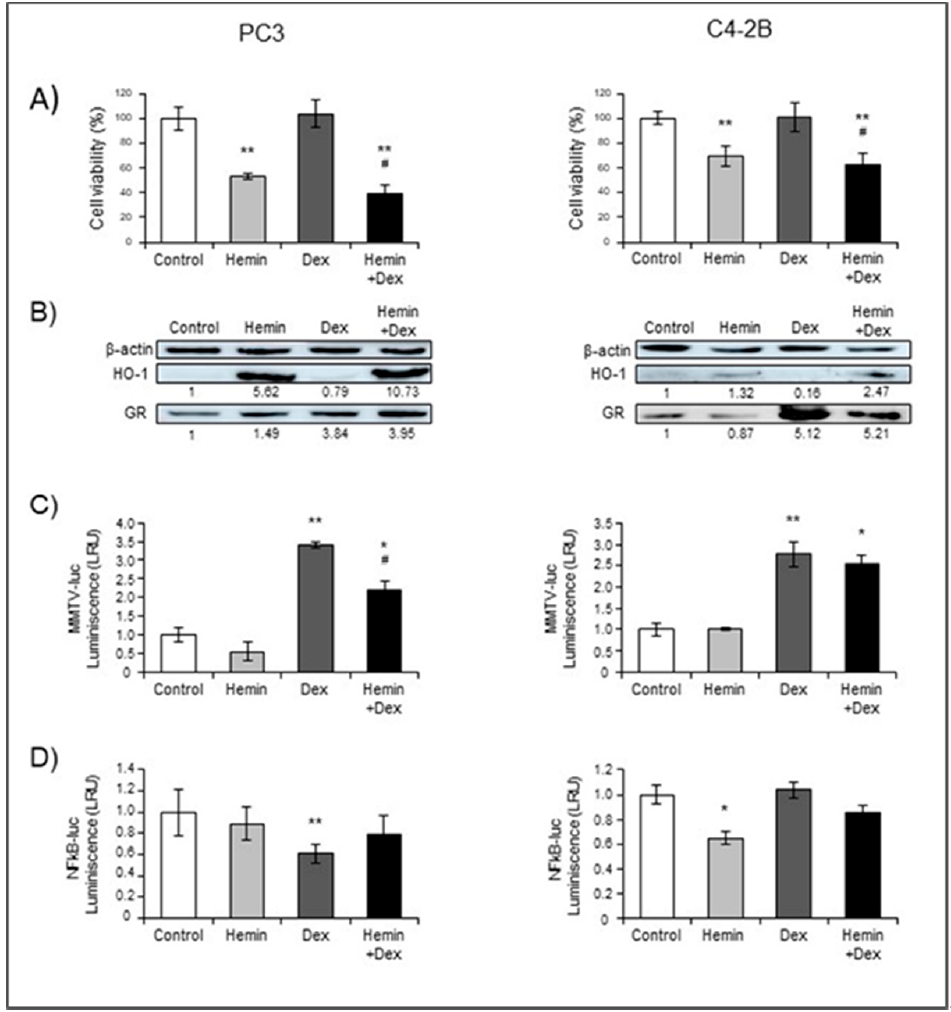
Figure 1. Hemin treatment modulates Dexamethasone-induced GR expression and signaling. PC3 and C4-2B cells were treated with Hemin (80 µ M for 24 h), Dexamethasone (Dex; 10 nM for 6 h post Hemin/PBS 24-h treatment), the combination of both drugs, or PBS as control. ( A ) MTS viability assay was performed and results are presented as percentage of viable cells compared to control (100%). ( B ) Western blot analysis showing HO-1, GR, and β -actin as loading control. Protein quantification was performed by densitometry analysis using ImageJ software. The numbers under the bands indicate the quantitation normalized to β -actin and control lane. One representative experiment is shown. Panels C and D depict reporter assays. Cell lines were transiently transfected with the MMTV-luc ( C ) or NFkB-luc ( D ) reporter plasmids, and after treatments, cells were lysed and luciferase activity assay was performed. Data were normalized to total protein values. Results are shown as mean ± SEM from at least three independent experiments; * p < 0.05 and ** p < 0.01 versus control cells, # p < 0.05 versus Dex treated